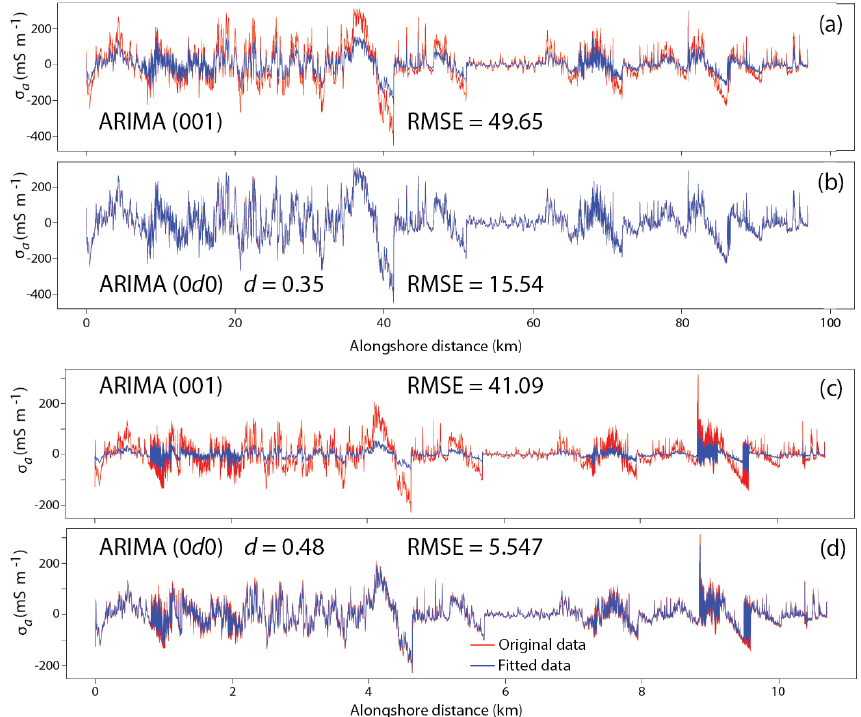
Figure 6. Examples of the worst-fit (a, c) and best-fit (b, d) ARIMA models for the 100 and 10km EMI surveys. Model results are shown for the processed (drift-corrected) σ a data. Residuals (RMSE) listed for each model give the standard deviation of the model prediction error. For each plot, original data are in red and fitted (model) data are in blue.